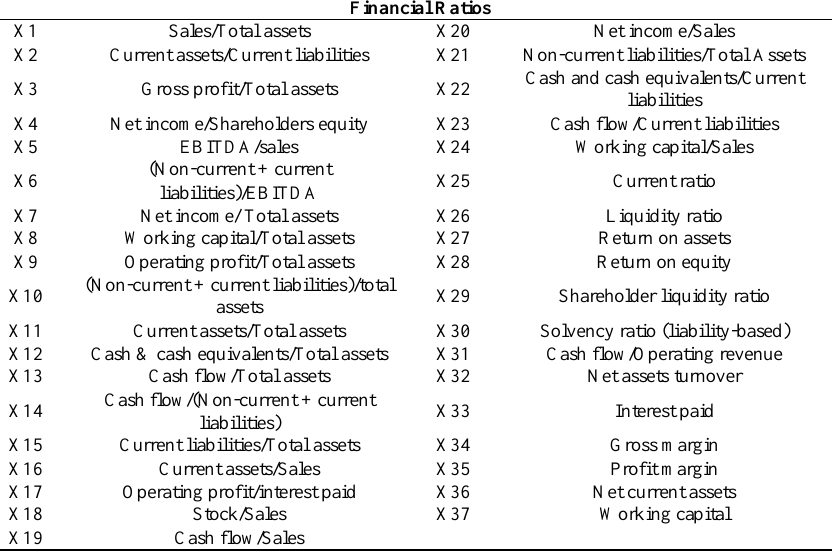
Table 1. Selected financial ratios